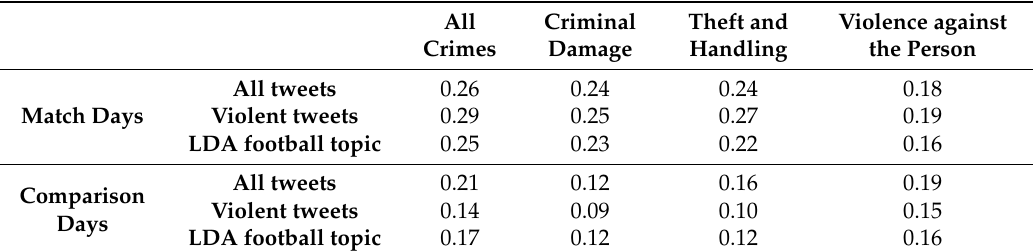
Table 4. Bivariate spatial autocorrelation between crime density and